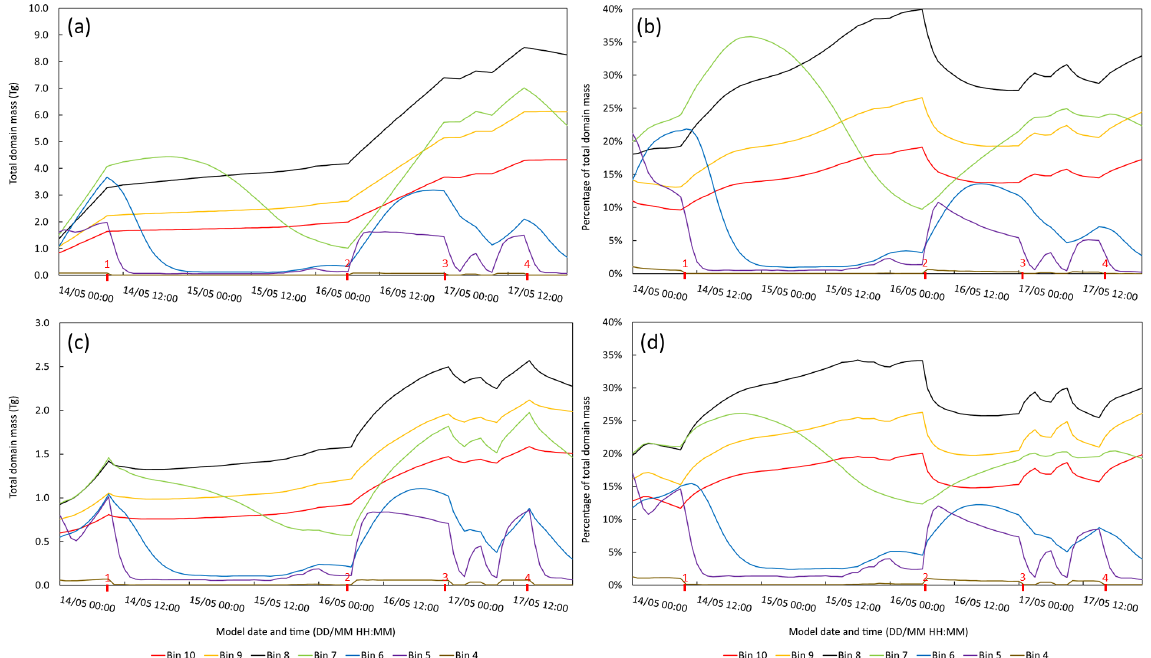
Figure 10. Total domain ash mass (a, c) and percent contribution to domain mass (b, d) for the modeled period between 14 and 18 May 2010 without (a, b) and with (c, d) aggregation code enabled. Red numbers on date/time axis denote major ( > 10%) changes in the erup- tion rate: (1) 14:00/09:00Z – decrease from 7.949 to 1.775Tg every 3h; (2) 16:00/06:00Z – increase from 1.175 to 7.949Tg every 3h; (3) 17:00/00:00Z – decrease from 7.949 to 1.056Tg every 3h; (4) 17:00/15:00Z – decrease from 7.949 to 0.966Tg every 3h. Note there are variable increases and decreases in the eruption rate between markers 3 and